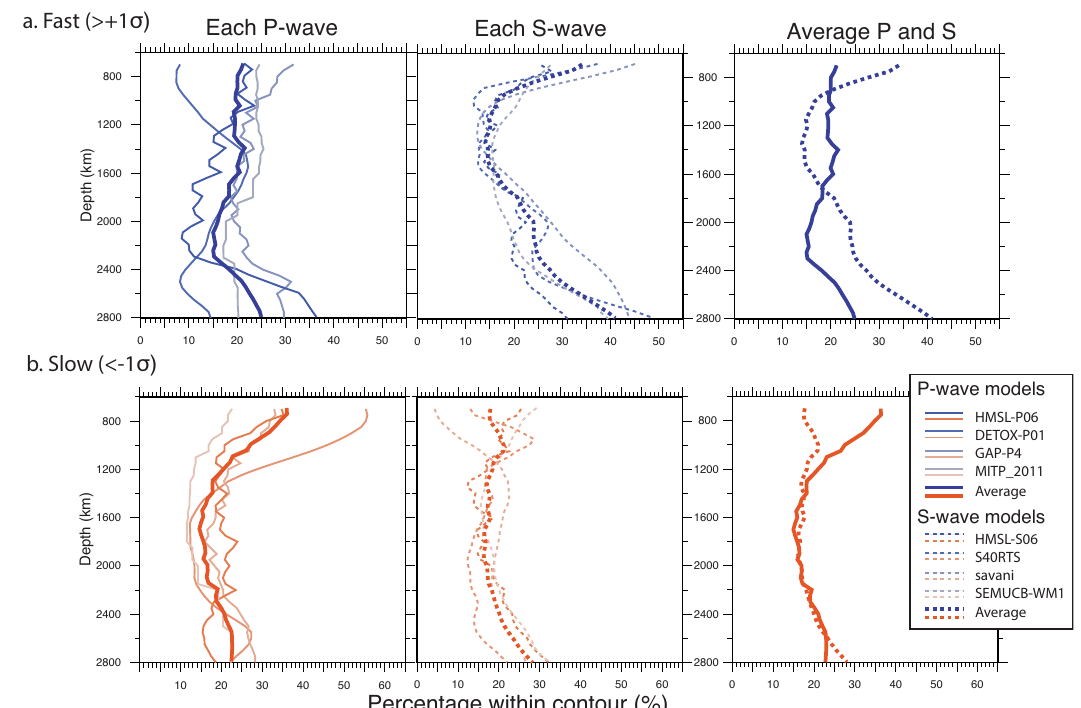
Fig. 4 Changes in surface area for the individual tomography models. Depth-dependent changes in surface area for the a fast (> + 1 σ from the mean), and b slow (< − 1 σ from the mean) regions, as applied to each of the 4 P-wave, and 4 S-wave tomography models. The individual model names and details are shown in Supplementary Figs. 2-3. The bold lines are the average of each panel, which are extracted and shown in the rightmost panels. This procedure is similar to that shown in Fig. 1b, c except without the vote map